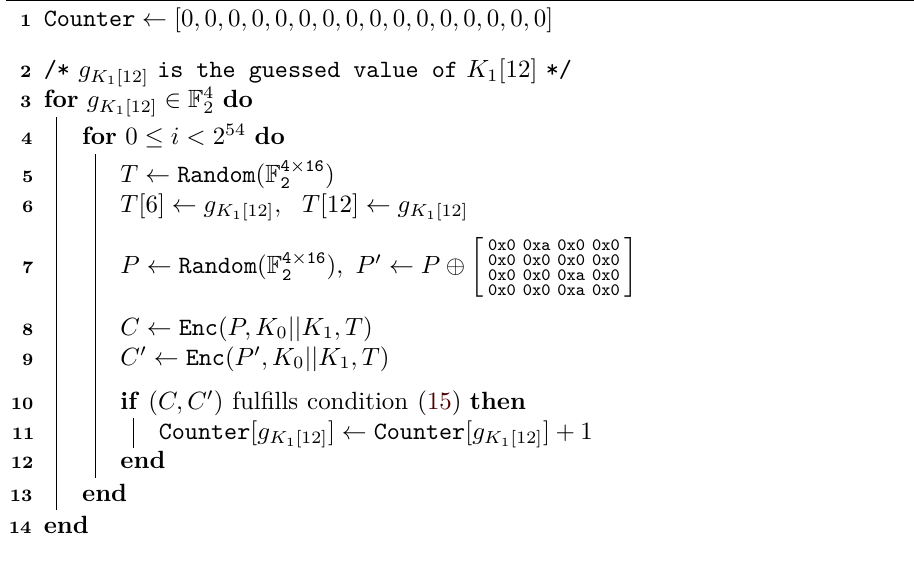
Algorithm 1: Recovering K 1 [12] based on the truncated differential shown in Figure